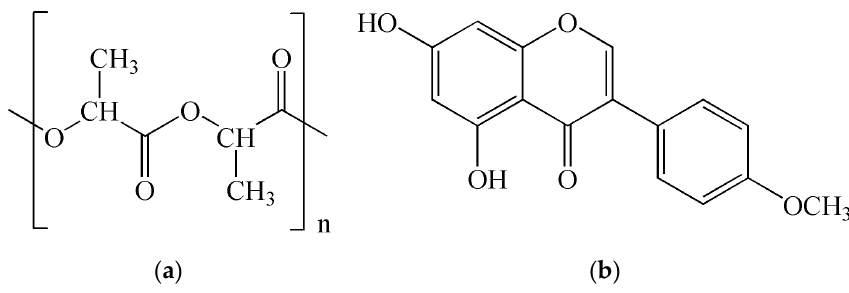
Figure 1. Structure of ( a ) poly(lactide) and ( b ) biochanin A.